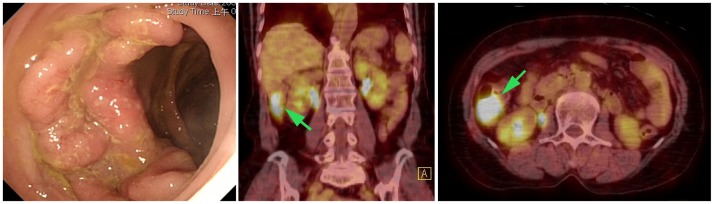
One ulcerated cancer with well-demarcated borders (4.0 cm in size) was identified by colonoscopy in the ascending colon.The results of colonoscopy were taken as the gold standard. FDG PET/CT imaging revealed an increased FDG uptake in a compatible location (arrow); therefore, the FDG PET/CT findings were considered as true-positive.